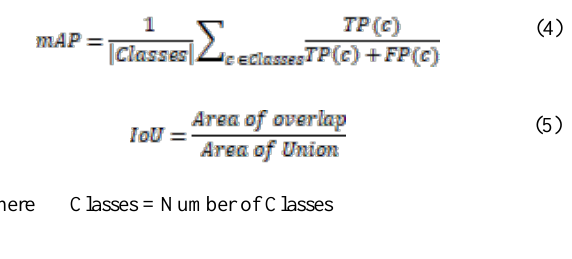
Figure 3 . Non-Maximum Suppression (NMS)